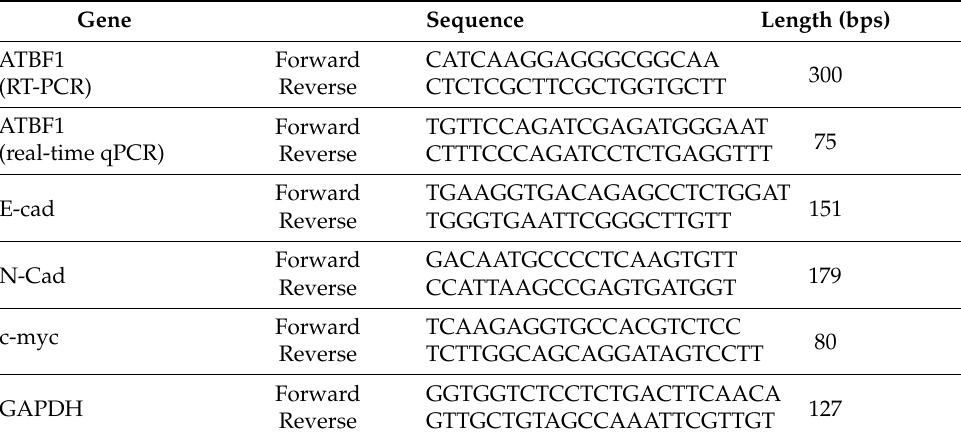
Table 1. Primer sequences for PCR